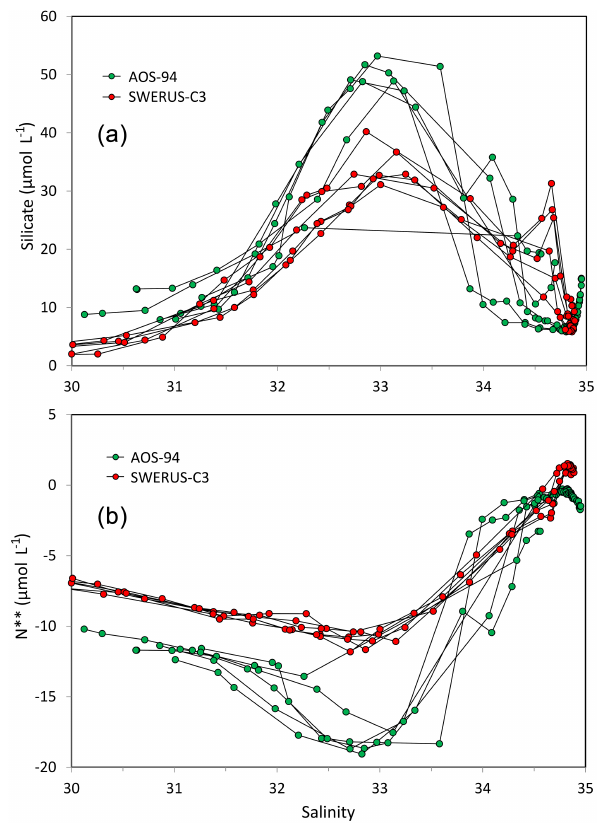
Figure 10. Silicate (a) and N ∗∗ (b) versus salinity in the Chukchi Abyssal Plain area; data from the Arctic Ocean Section in 1994 in green (stations marked by green points in Fig. 1b) and from SWERUS-C3 in red (section F in Fig. 1b).